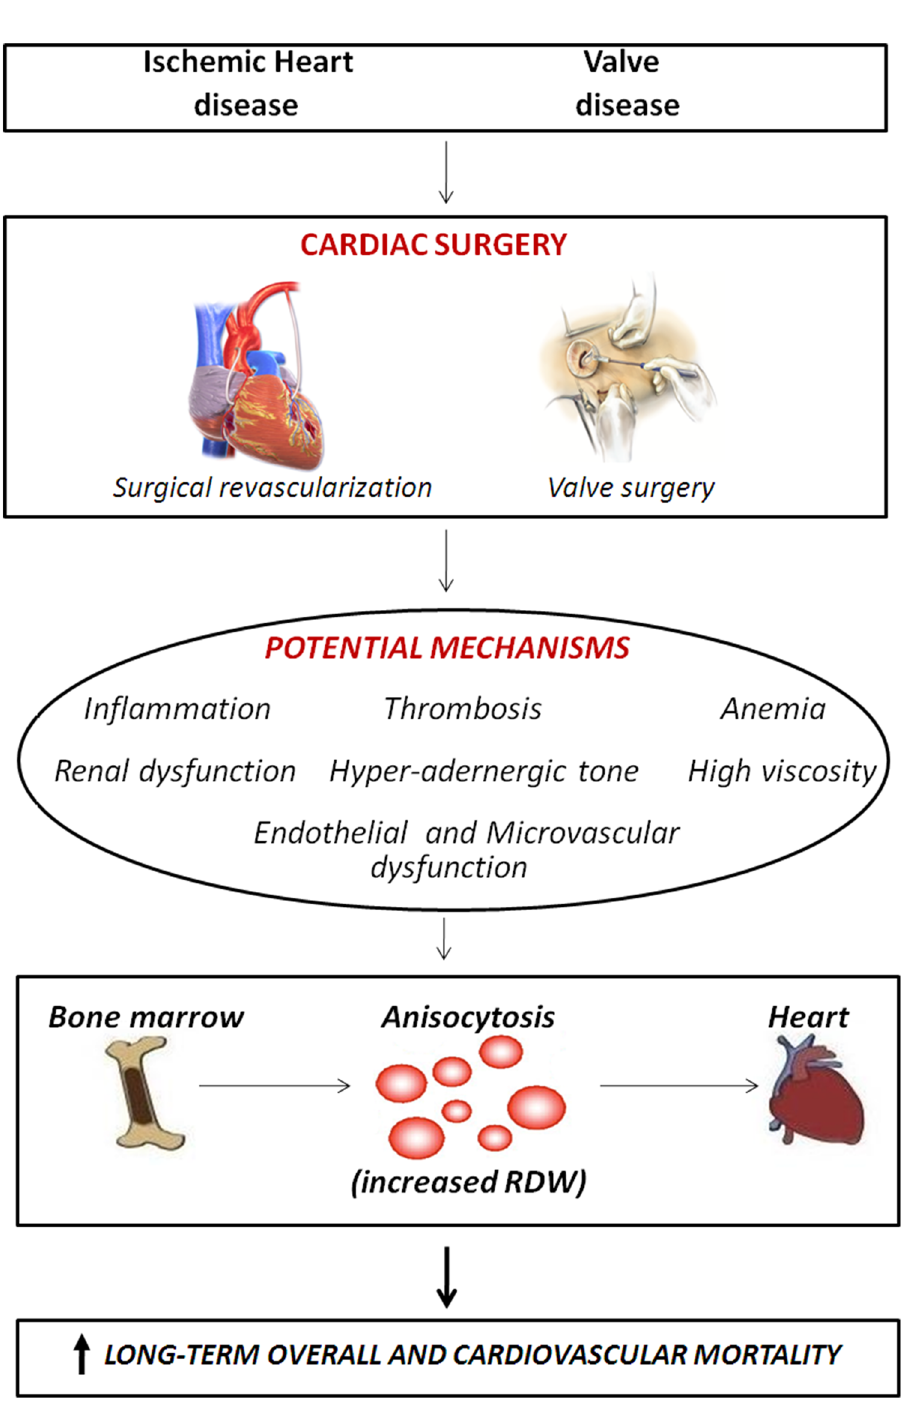
Figure 3. Possible patho-physiological mechanisms linking anysocitosis to long-term mortality after cardiac